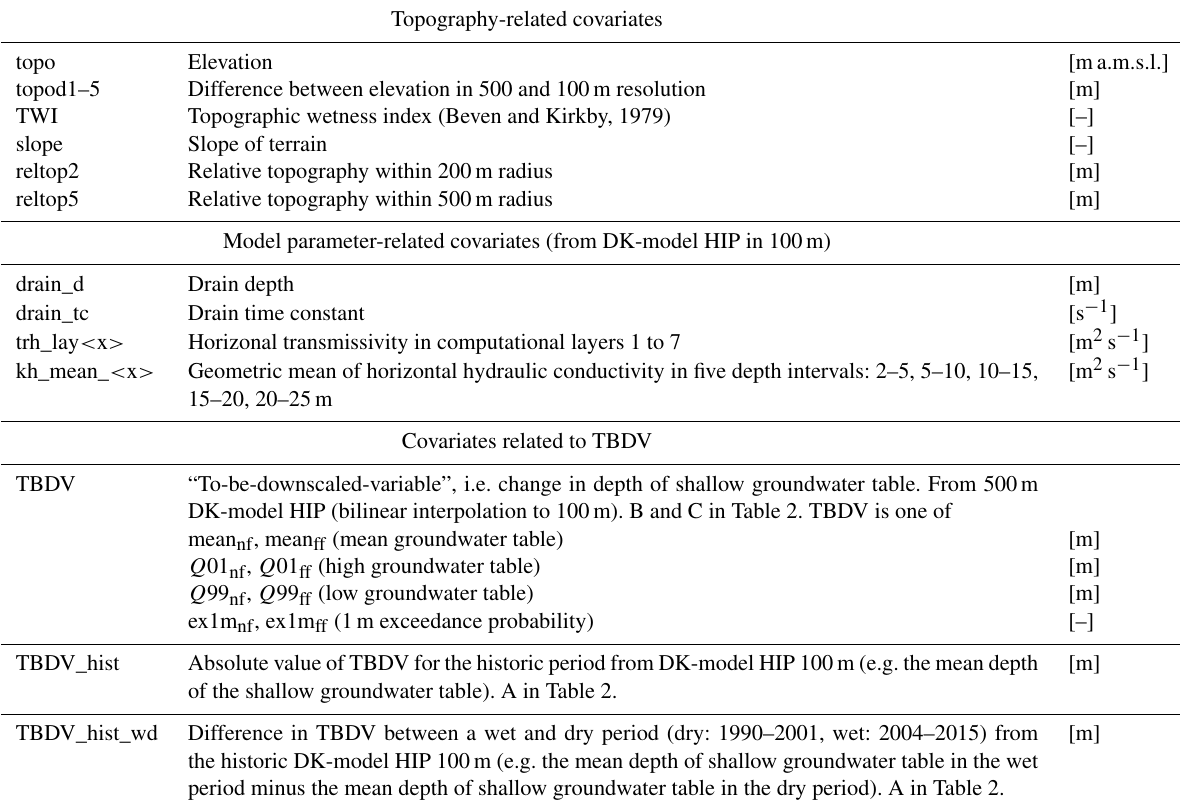
Table 3. Overview of the covariates.